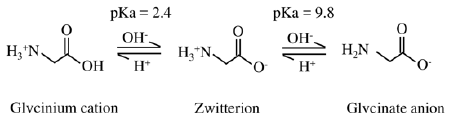
Figure 2. Options to increase gold dissolution rate in alkaline glycine solutions (summarized from [12–14]). 2Au (s) + 4NH 2 CH 2 COO − + 1/2O 2 (g) + H 2 O → 2Au(NH 2 CH 2 COO) 2− + 2OH − , ∆G° (25 °C) = 195.8